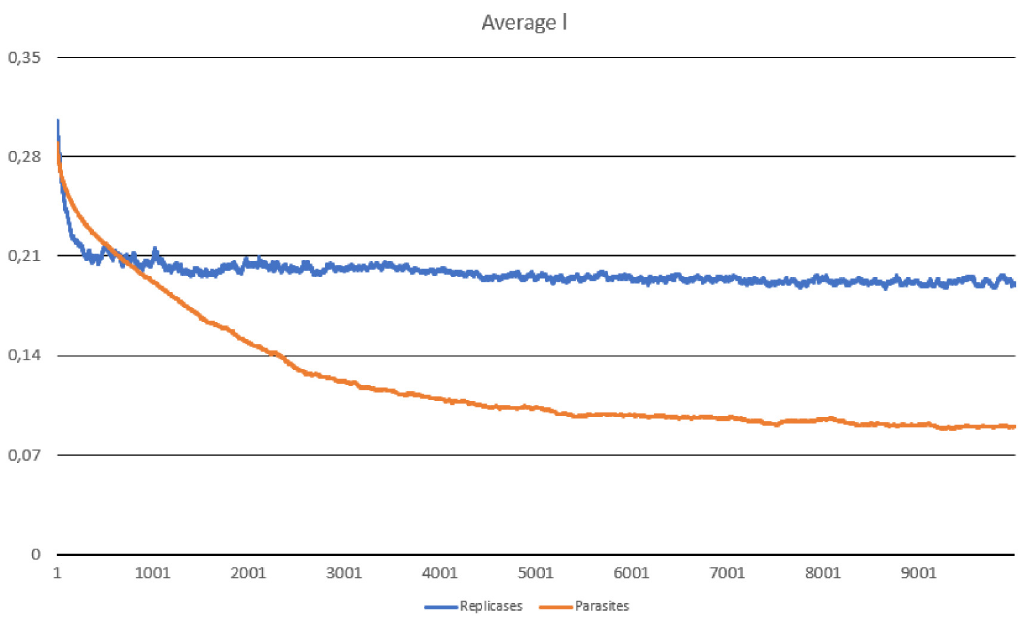
Fig 7. The average probability of being in the folded state, computed for parasites and replicases in Scenario 2.